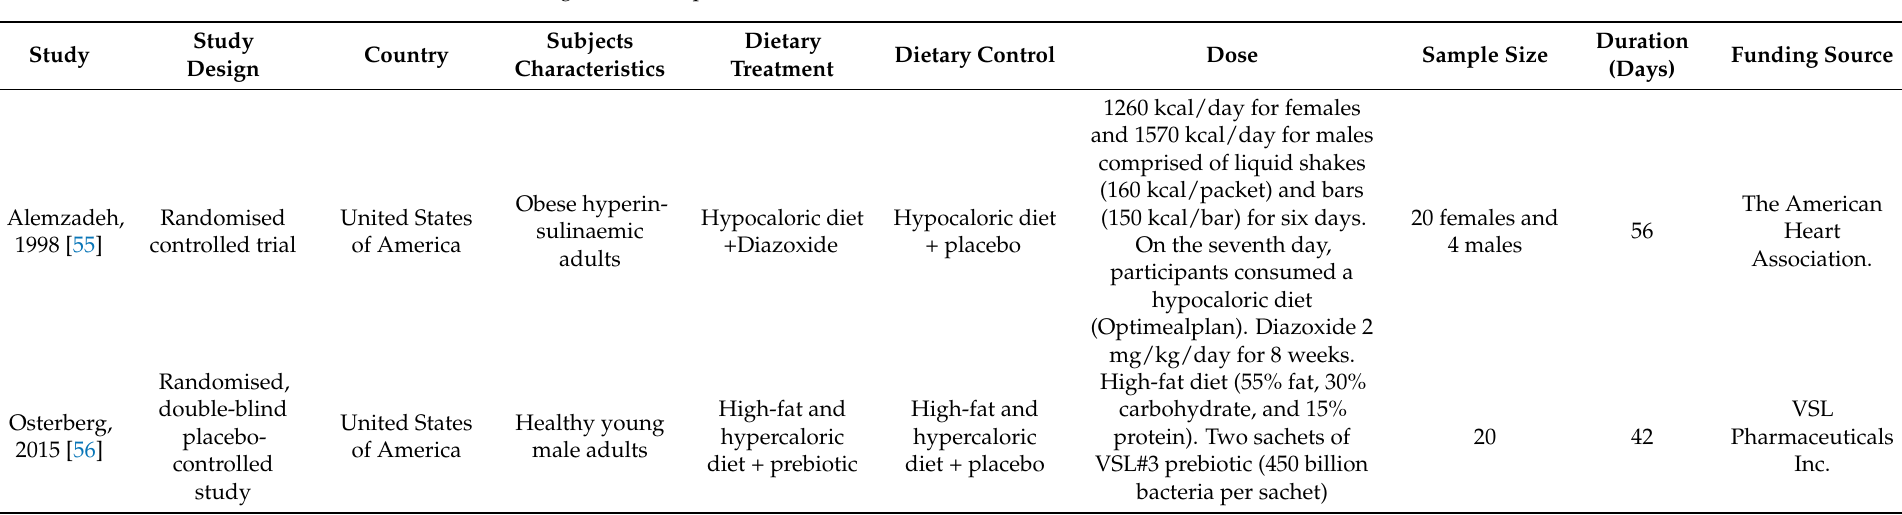
Table 3. IVGTT and AIRg trials